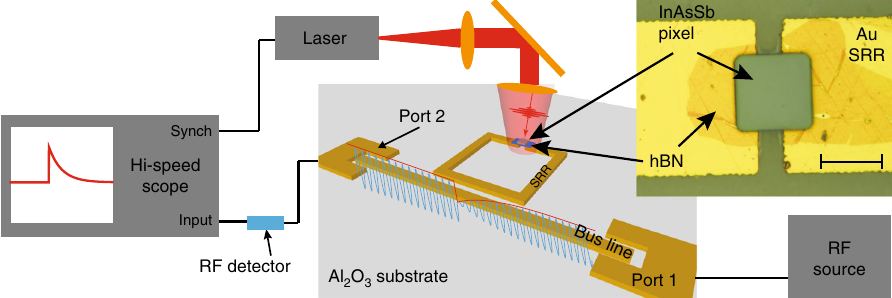
Fig. 1 Overview of the proposed technique. A radio frequency (RF) source outputs a continuous wave (CW) microwave signal at the resonant frequency of the split-ring resonator (SRR) through port 1. A pulsed laser excites electron-hole pairs (EHPs) in the material under study (an indium arsenide antimonide pixel in this case) loaded within the split gap of the resonator. The EHPs modulate the CW signal on the microstrip busline, whose envelope function is detected by a Schottky diode RF detector. The modulated signal is then sent to a high-speed oscilloscope synchronized to the laser repetition rate. A micrograph shows both the pixel and a thin layer of insulating hexagonal boron nitride (hBN) loaded into the SRR; the scale bar in the image is 20 μ